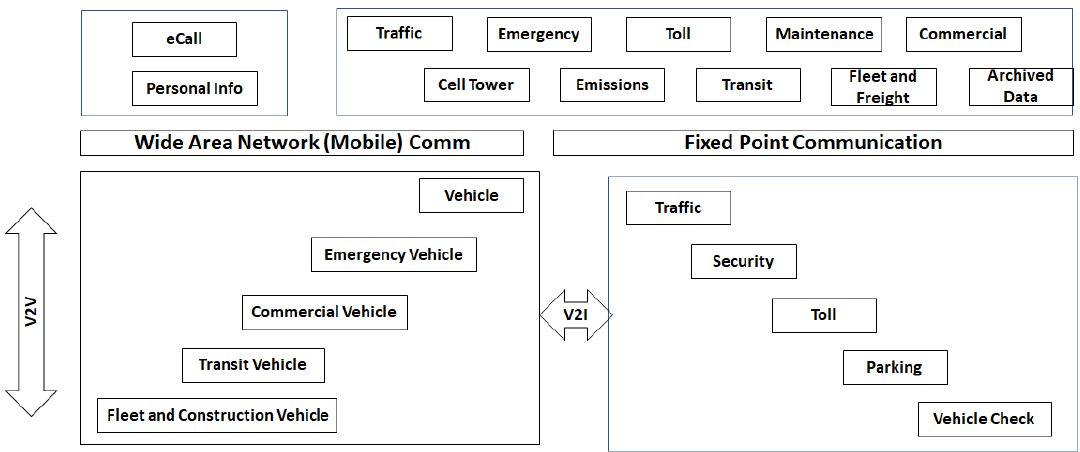
Figure 8. United States Department of Transportation (US DOT) Intelligent Transportation Systems (ITS) National